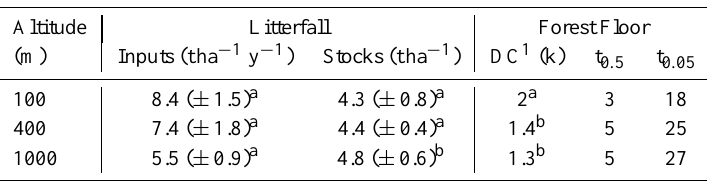
Table 4. Litterfall inputs and stocks in different altitudes and litter decomposition rates ( k ) and time (months) for decay of 50% ( t 0 . 5 ) and 95% ( t 0 . 05 ). Data represents six months of sampling (March through August 2007). Different letters represent statistically significant differences among altitudes.